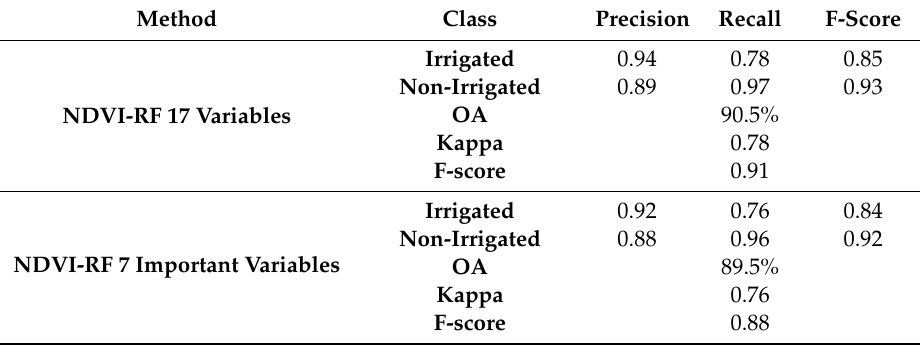
Table 5. The values of the overall accuracy, Kappa, F-score, precision, and recall obtained from the RF classifier using the 17 normalized di ff erential vegetation index (NDVI)-PC and the seven important NDVI PC values.